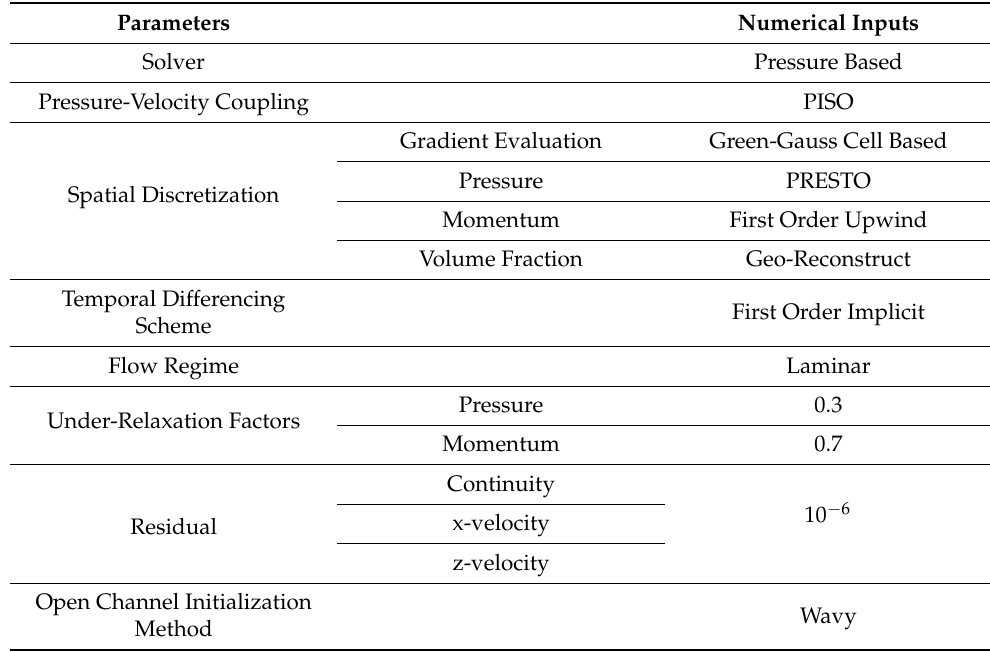
Table 5. Methods adopted in numerical simulations.